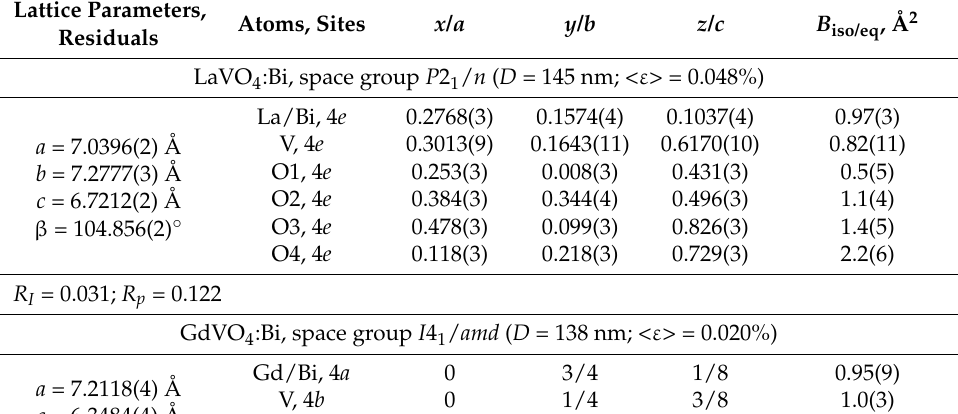
Table 3. Lattice parameters, fractional coordinates and isotropic displacement parameters in R VO 4 :Bi structures and corresponding microstructural parameters of the